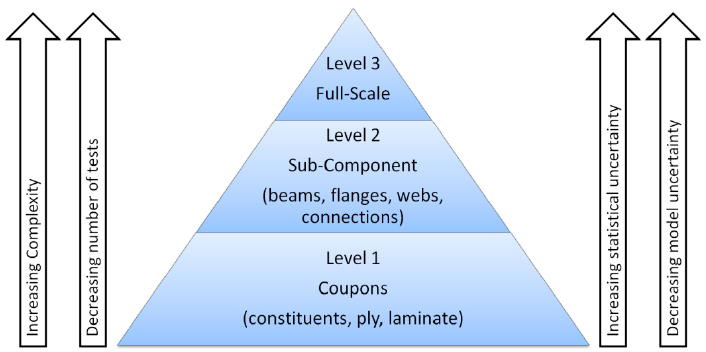
Figure 7. Illustration of type of tests, which can be performed for assessment of load bearing capacity of wind turbine blades.